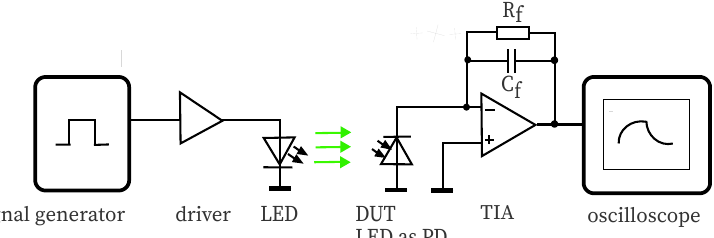
Figure 4. This block diagram depicts the configuration for determination of the rise/fall time of LEDs deployed as photodetectors. The source is configured as in Figure 3. The irradiated DUT is connected to a transimpedance amplifier. Its pulse shape is recorded by a digital